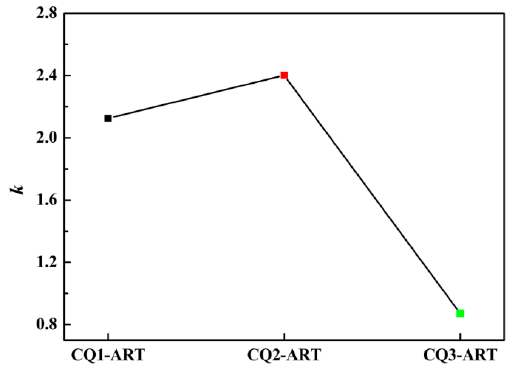
Figure 7. k -parameters for different samples.